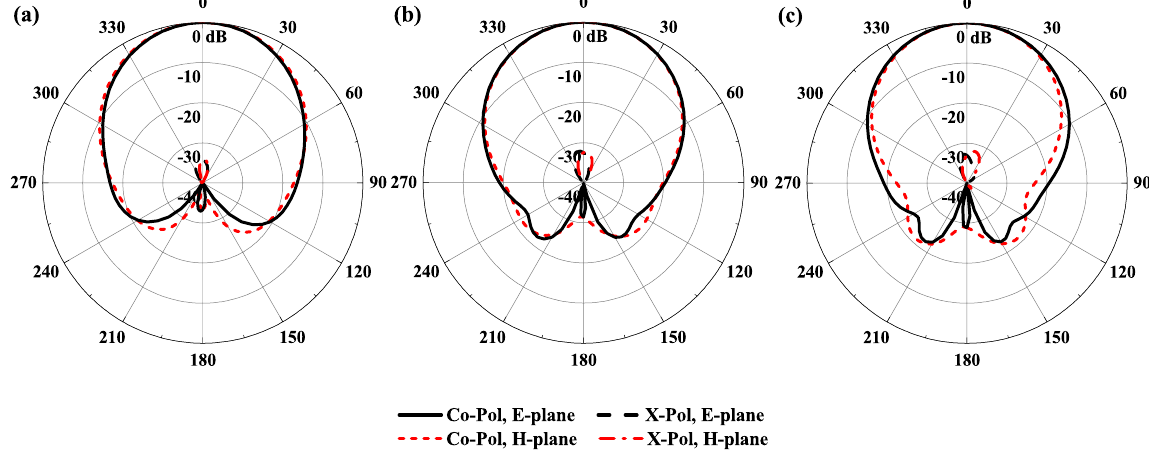
Figure 4. Simulated radiation pattern of the proposed antenna element at different frequencies throughout the operating band. ( a ) f = 0.85 THz, ( b ) f = 0.95 THz, and ( c ) f = 1.05 THz.